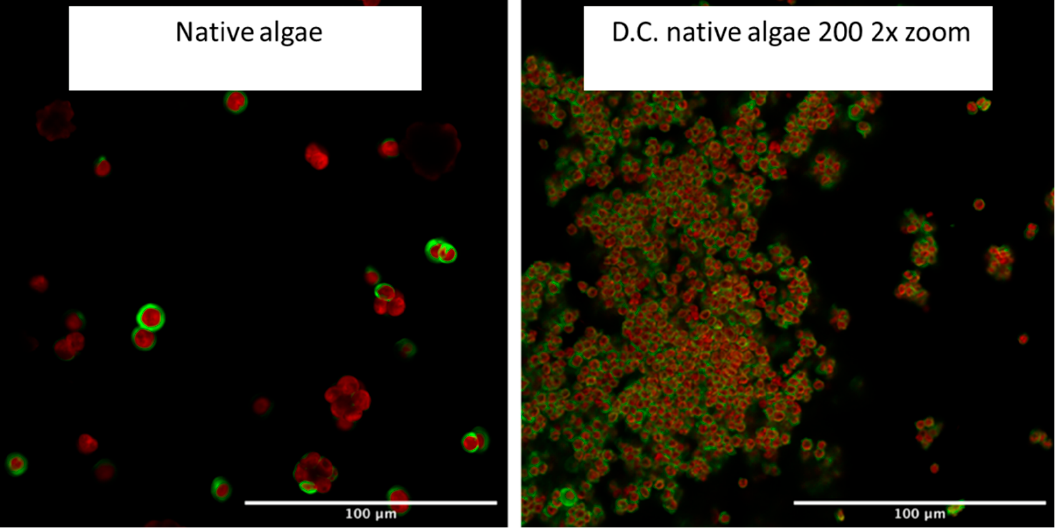
Figure 8. Laser Confocal Microscopy Images of initial native algal biomass and defibrillated celluloses 200 from native biomass at 2× zoom.